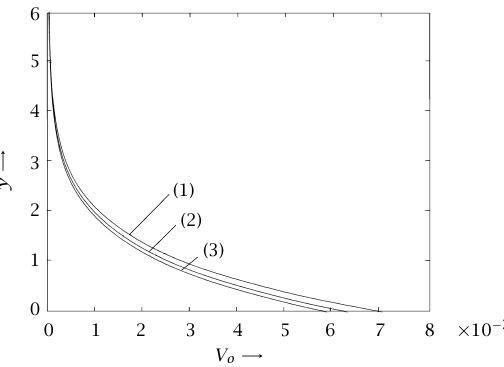
Figure 4.6 . Outer flow transverse velocity component of fluid V o for R = 500, 4 = 0 . 05, t = 1 . 5. (1) X = − 1, λ = 0 . 01, (2) X = − 1, λ = 0 . 36, (3) X = − 1, λ = 0 . 71.